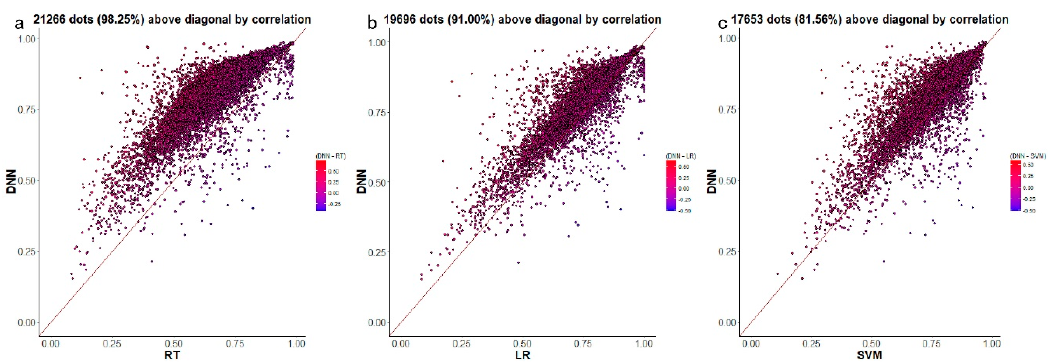
Figure 9. The predictive PCC of each target gene by D-GPM compared with RT, LR, and SVM for MBV-te. Each dot represents one out of the 21,645 target genes. The x-axis is the PCC of each target gene obtained by the above-mentioned three machine learning techniques, and the y-axis is the PCC of each target gene obtained by D-GPM. The dots above the diagonal indicate that D-GPM achieves a higher PCC value compared with the other method. ( a ) D-GPM versus RT. ( b ) D-GPM versus LR. ( c ) D-GPM versus SVM.